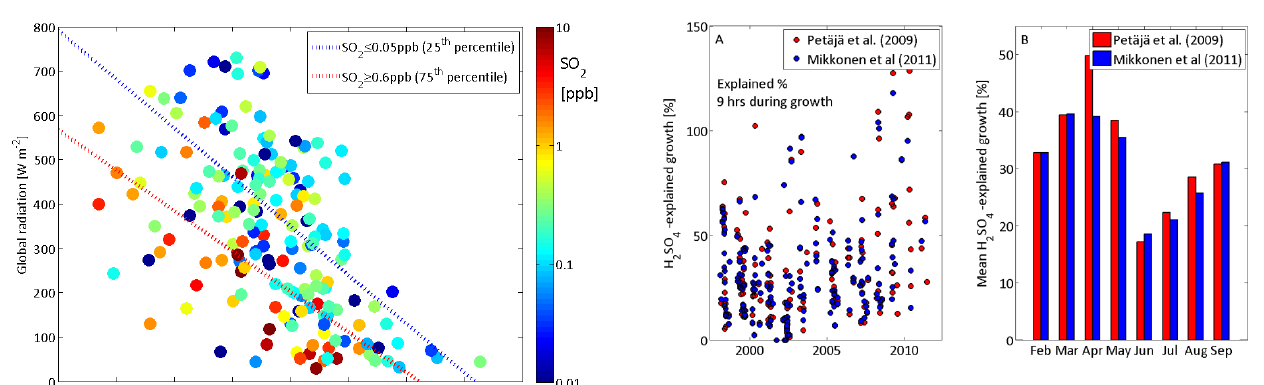
Fig. 12. The time series of the percentage which H 2 SO 4 explains of the growth (A) , its yearly variation (B) . Months with fewer than Figure 12 The timeseries of the percentage which H 2 SO 4 explains of the growth (A), its 3 five cases where the percentage has been calculated have been dis- yearly variation (B). Months with less than 5 cases where the percentage has been calculated 4 have been discarded. 5